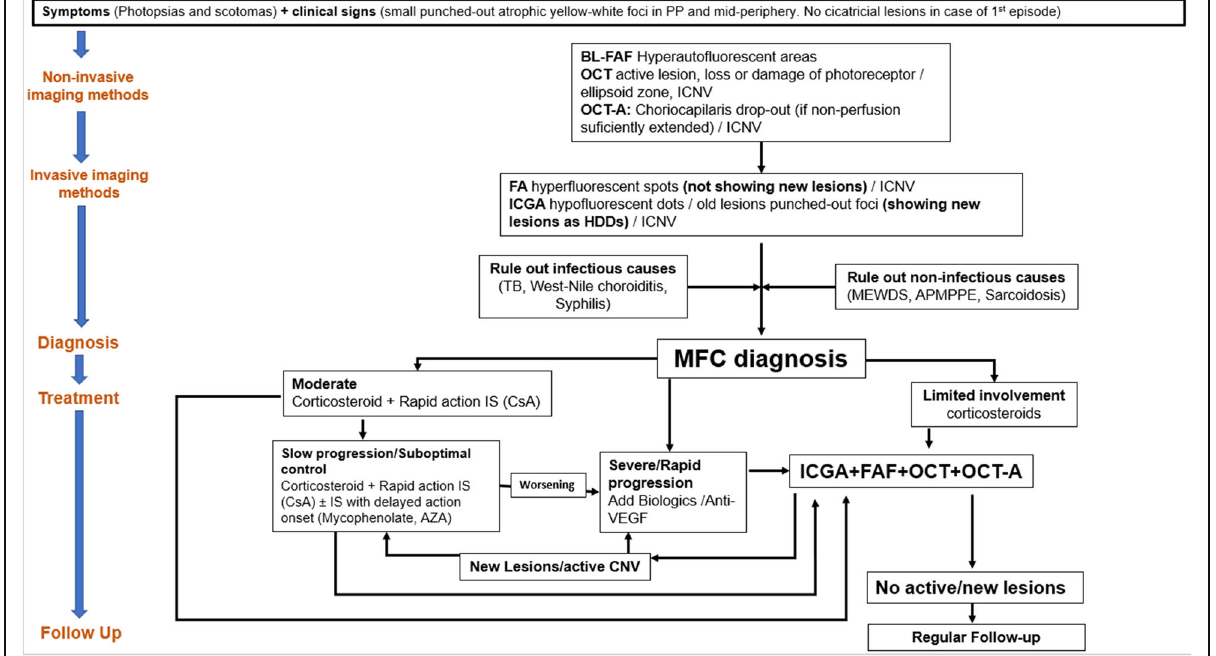
Fig. 13 MFC: Diagram of Imaging appraisal in practice; diagnosis and management following the logical sequence of exams. PP: posterior pole. OCT: optical coherence tomography. iCNV: inflammatory choroidal neovascularization. BL-FAF: blue light autofluorescence. OCT-A: OCT- angiography. FA: fluorescence angiography. ICGA: indocyanine green angiography. HDDs: hypofluorescent dark dots. TB: tuberculosis. MEWDS: